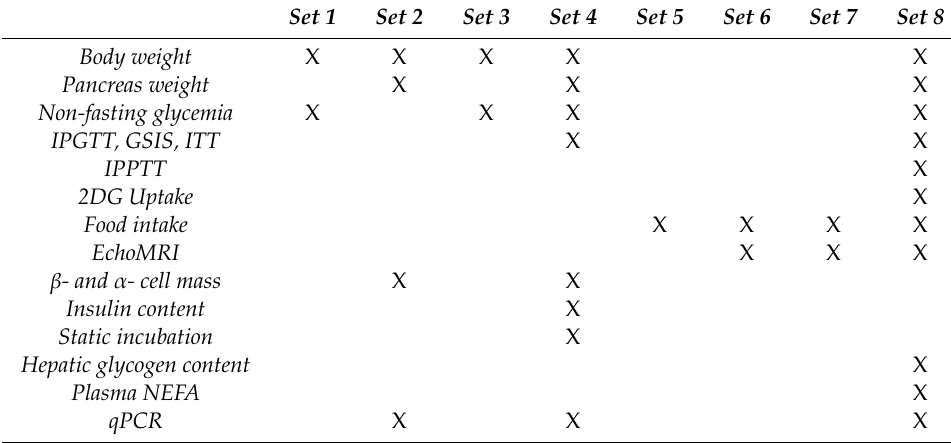
Table 1. Distribution of experiments by set of